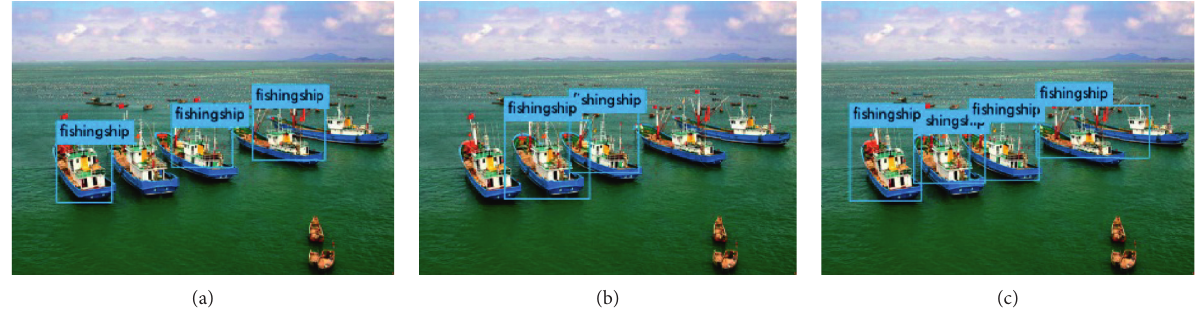
Figure 5: The comparison of detection effect among the method of YOLOv2 (a), YOLOv3 (b), and the improved RDCNN